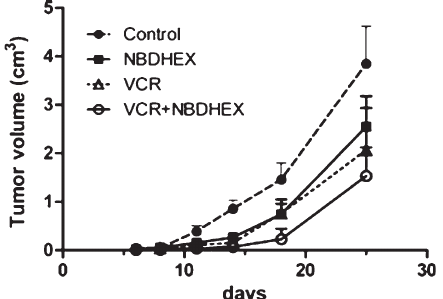
Fig. 5. Inhibition of TC-71 tumour growth in nude mice by NBD- HEXtreatmentwithorwithoutvincristine(VCR).Miceweretreated peros startingfromday6dailyforfivetimesweeklywithNBDHEX (40mg/kg)orwithvehiclealone(controls).Incombinedtreatments, vincristine (1mg/kg/d i. p.) was added on days 6 and 7. Points , tumour size mean; bars , SE.